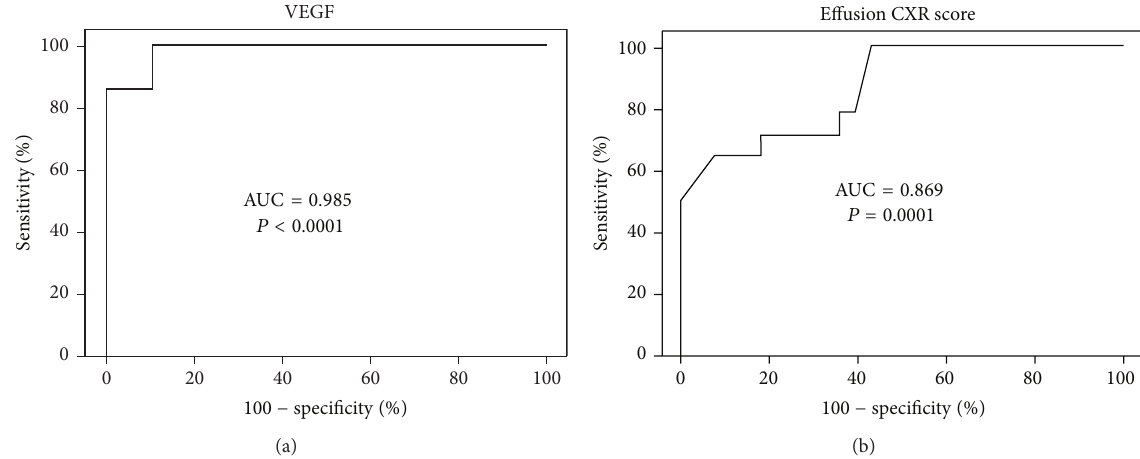
Figure 1: Receiver operating characteristic curves for (a) effusion vascular endothelial growth factor (VEGF) level and (b) effusion chest radiography (CXR) score to predict residual pleural thickening (RPT) in tuberculous pleural effusion (TBPE). AUC = area under the curve.